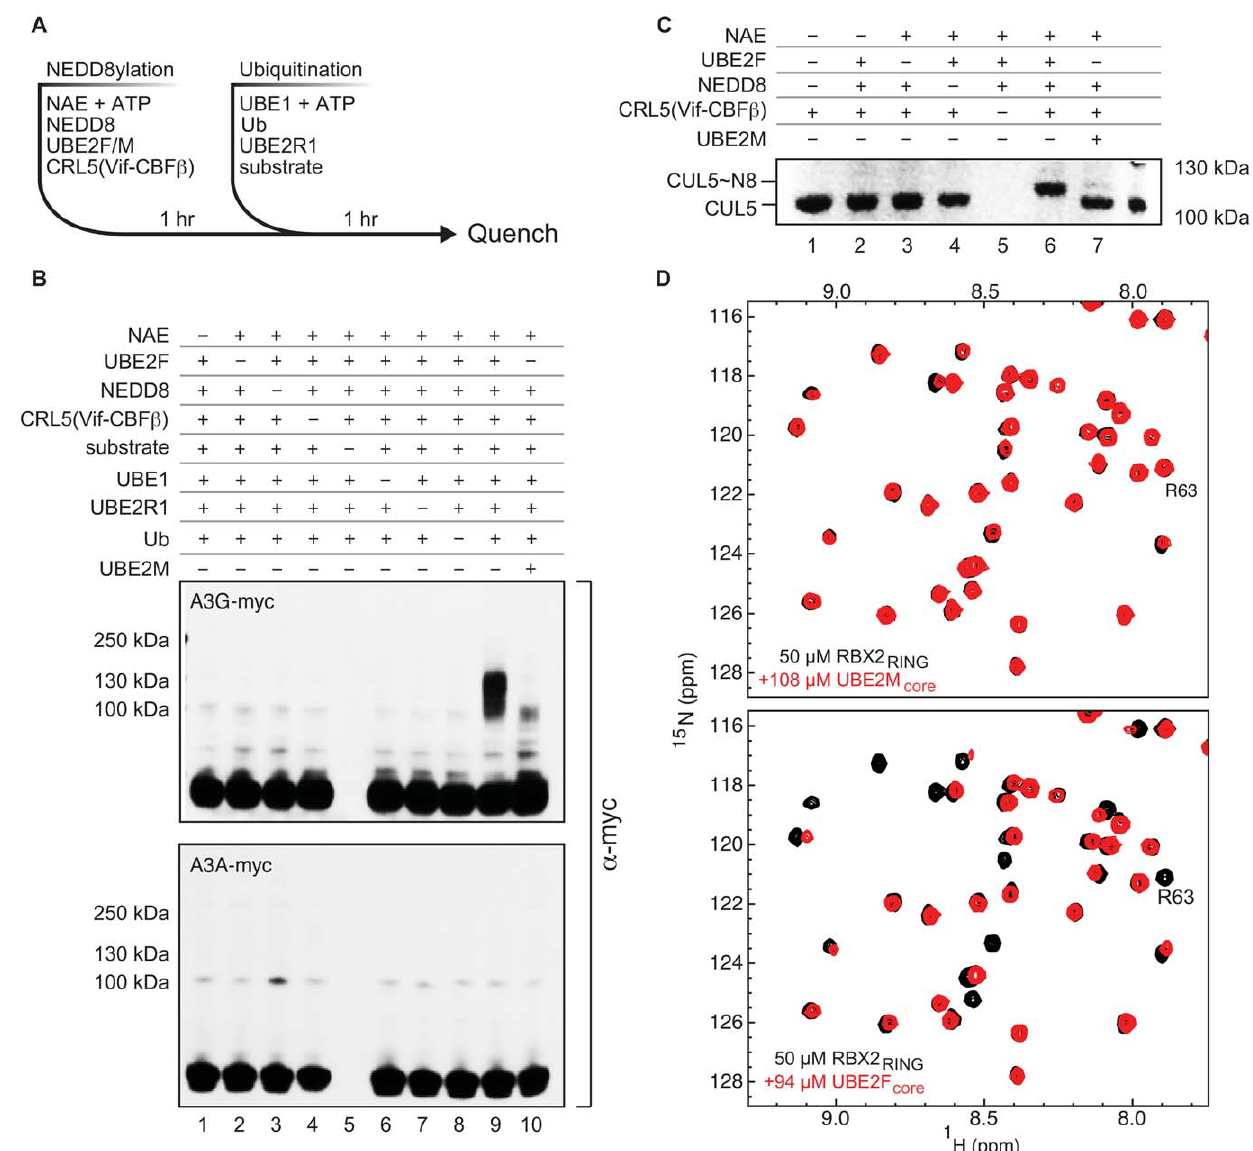
Figure 3. UBE2F is required for activation of CRL5 Vif-CBFß invitro . A, Diagram of the ubiquitination protocol used in panel B . B, In vitro ubiquitination of A3G by recombinant CRL5 Vif-CBFß with UBE2R1 as ubiquitin conjugating enzyme requires UBE2F. Immunoblots of ubiquitination reactions containing myc-tagged A3G as the substrate show high-molecular weight polyubiquitin chains, require all protein components of the ubiquitin and NEDD8 activating systems and are only observed when UBE2F (lane 9) but not when UBE2M (lane 10) is used as NEDD8 conjugating enzyme. A3A is not susceptible to Vif and was used as a negative control. C, Coomassie-stained SDS-PAGE of NEDD8ylation ‘‘pulse’’ reaction indicates that under conditions used in panel B indicate CUL5 is completely NEDD8ylated by UBE2F; only a minor fraction ( , 5%) is NEDD8ylated by UBE2M. D, 15 N-HSQC spectral overlays of RBX2 RING in the presence and absence of , 100 m M, unlabeled full-length UBE2M (top) or UBE2F (bottom).